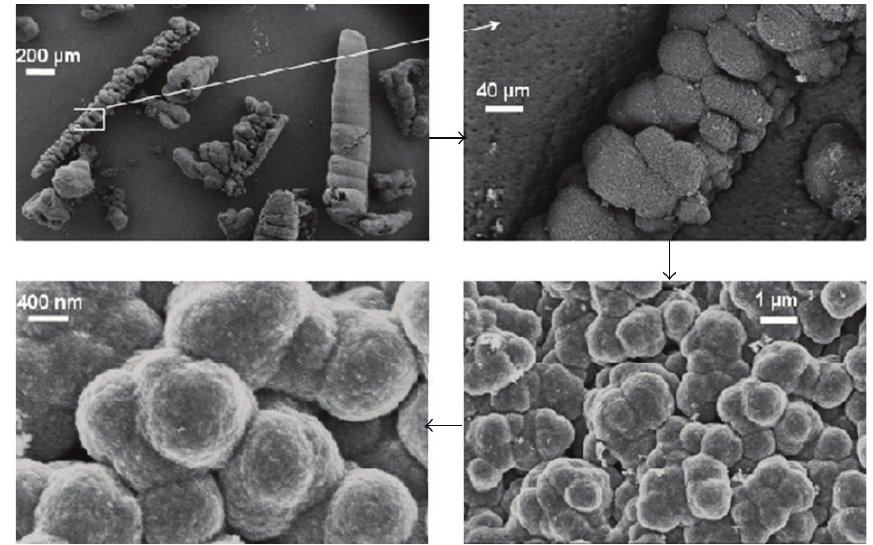
Figure 7: SEM observation of rough hair structure of